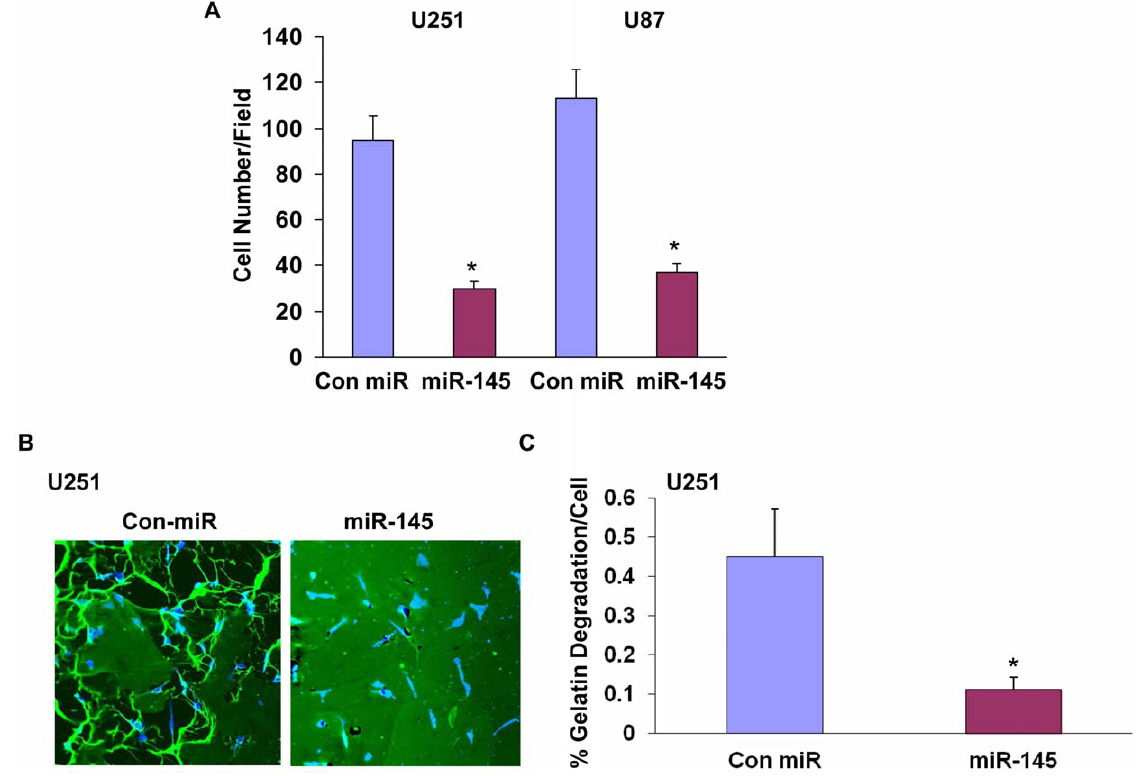
Figure 3. miR-145 mimic inhibits glioma cell invasion. miR-145 transfected U251 cells or U87 cells were plated on the top compartment of a Boyden chamber. After 8 h of incubation, cells that traversed the Matrigel-coated filters were stained and counted (A). U251 cells, transfected with miR-control or miR-145 mimic, were seeded on FITC-gelatin coated coverslips for 17 h. Cells were stained with an anti-cortactin antibody conjugated to Cy5 (B). The percentage of gelatin degradation per cell was determined in 10 fields (C). The results are the mean 6 SE of three different experiments. *P , 0.001.